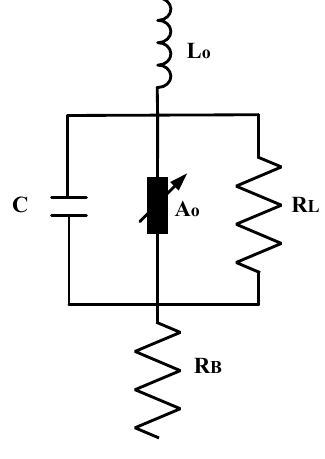
Figure 2. Basic ZnO element model [1,9].